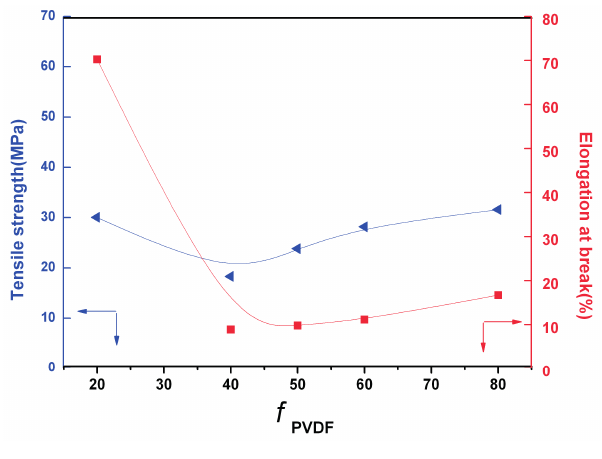
Figure 4. Variations of the tensile strength and the tensile elongation of PA11/PVDF/VA-MA (5 wt%) blend versus volume fraction of